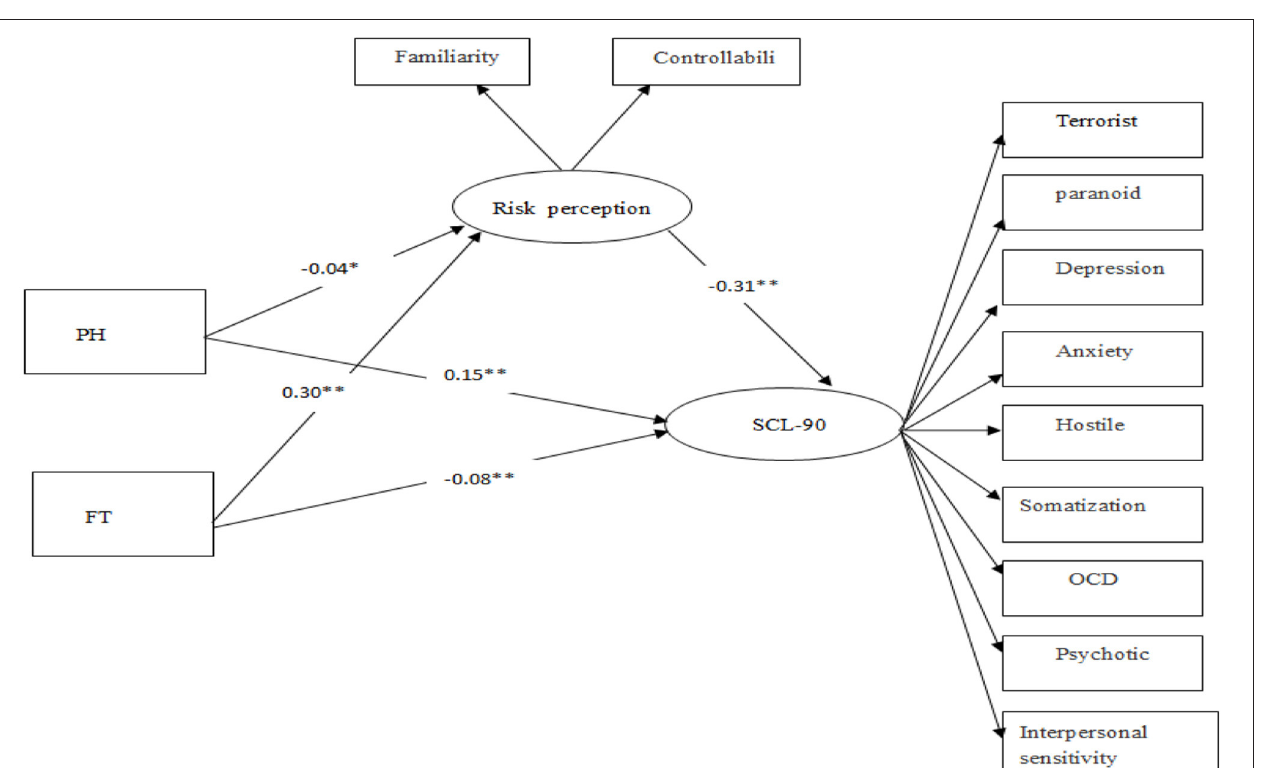
variable of RP, we propose a mediator model in